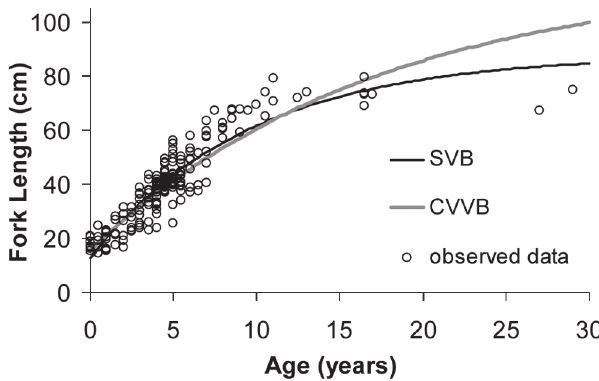
Fig. 7. Von Bertalanffy growth curves fitted to length-at-age from sectioned otoliths data for both sexes of the dog snapper Lutjanus jocu from Abrolhos Bank, with two assumptions: SVB = Constant variance for all ages and CVVB = Constant coefficient of variation for all